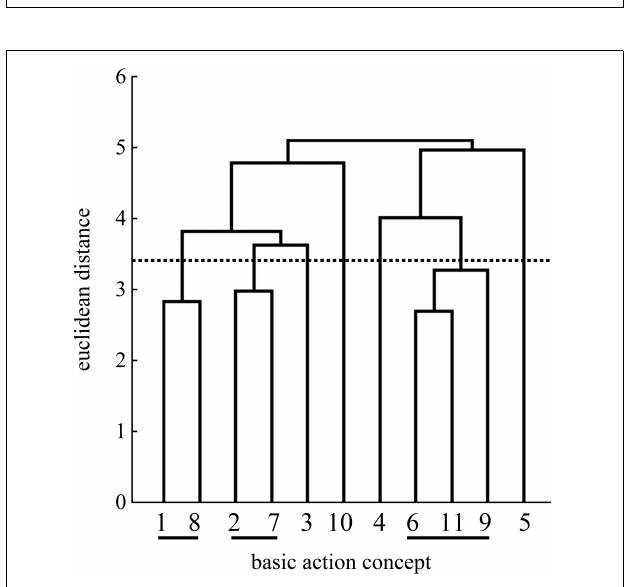
FIGURE 7 | Mean group dendrogram of the explicit group’s ( n = 15) tennis serves on the pretest.